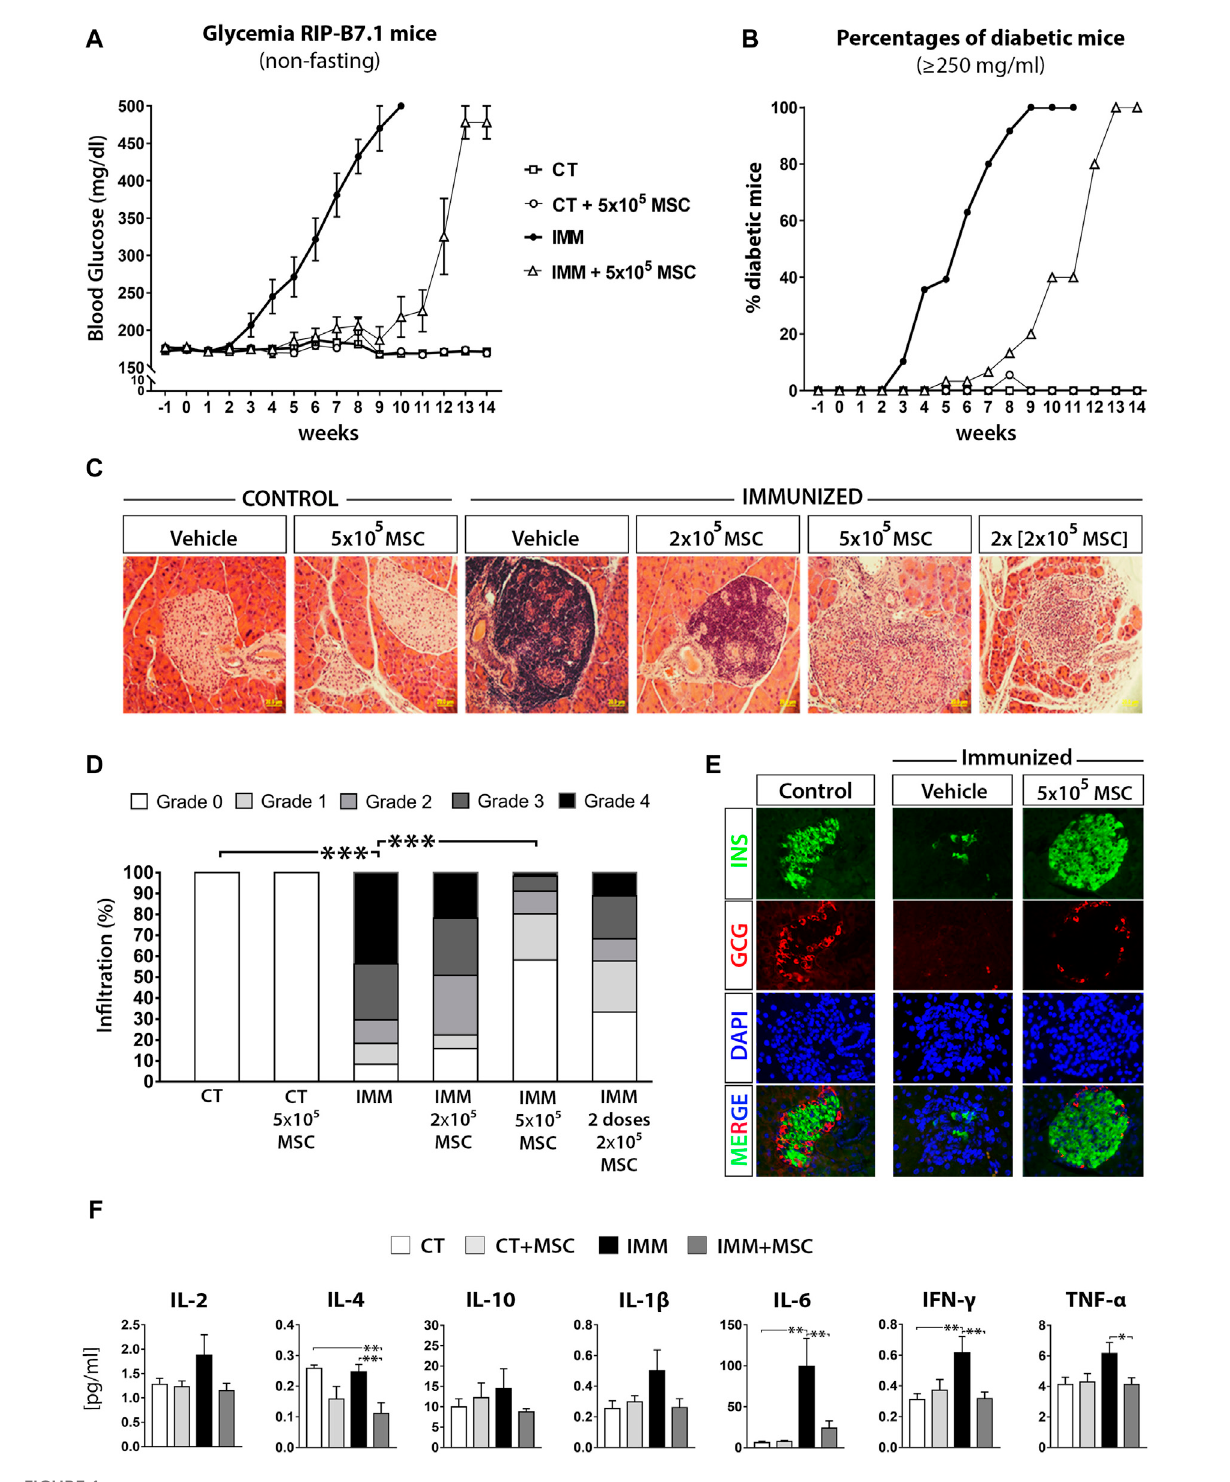
UC-MSC transplantation delay the onset of experimental autoimmune diabetes (EAD) in immunized RIP-B7.1 mice, reducing insulitis and normalizing plasmatic cytokine pro fi le during the protective phase. (A) Summary measurements of non-fasting blood glucose in control (CT) and immunized (IMM) RIP-B7.1 mice transplanted with vehicle or 5 × × 10 5 UC-MSC, recorded until 14 weeks post transplantation. (B) Summary percentages of diabetic RIP-B7.1 mice ( ≥ 250 mg/dL) into different experimental groups. (A, B) Values are means ± s. e.m. of n = 18 mice for CT and CT+5 × 10 5 UC-MSC, n =28forIMNand n =31forIMM+5×10 5 UC-MSC. (C) Representativehematoxylinandeosin(H&E)histologicalstainingofpancreaticsections from CT and IMM-RIP-B7.1 mice at 7 weeks post-transplantation with vehicle or 5 × 10 5 UC-MSC (40X magni fi cation). (D) Insulitis scores as a grade of 0 – 4 according to percentage of in fi ltrated islets. ( n = 4 mice per group). (E) Pancreatic sections from CT and IMM RIP-B7.1 mice at 7 weeks post- transplantation with vehicle or 5 × 10 5 UC-MSC were co-immunostained for insulin (green) and glucagon (red). Nuclei are stained with DAPI